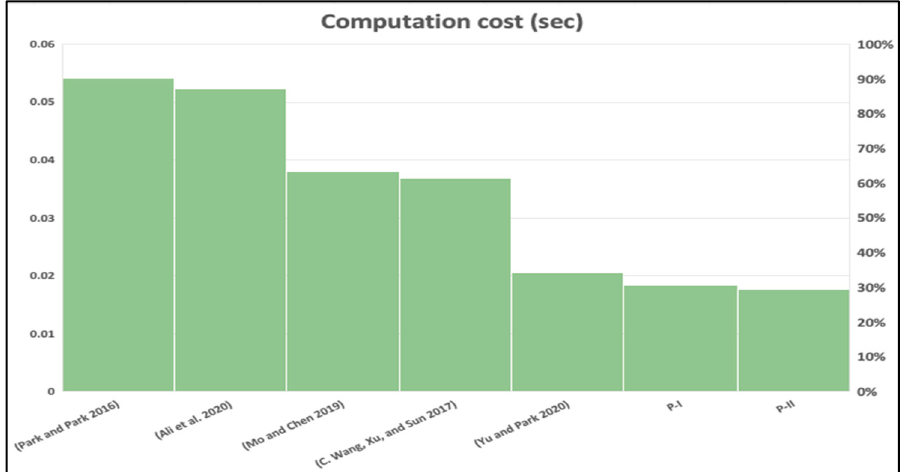
Figure 16. Computation time in foreign network node. Sensors 2020 , 20 , x FOR PEER REVIEW